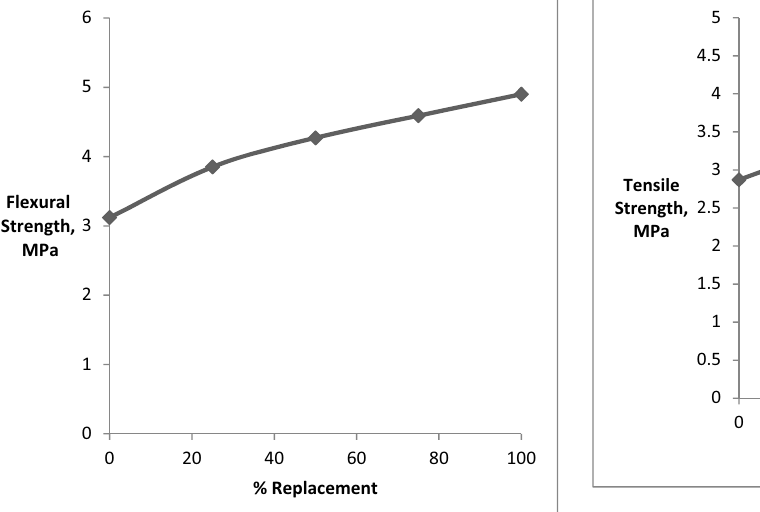
Figure 8: Relation between % replacement and tensile strength of concrete modi fi ed with PC superplasticizer.